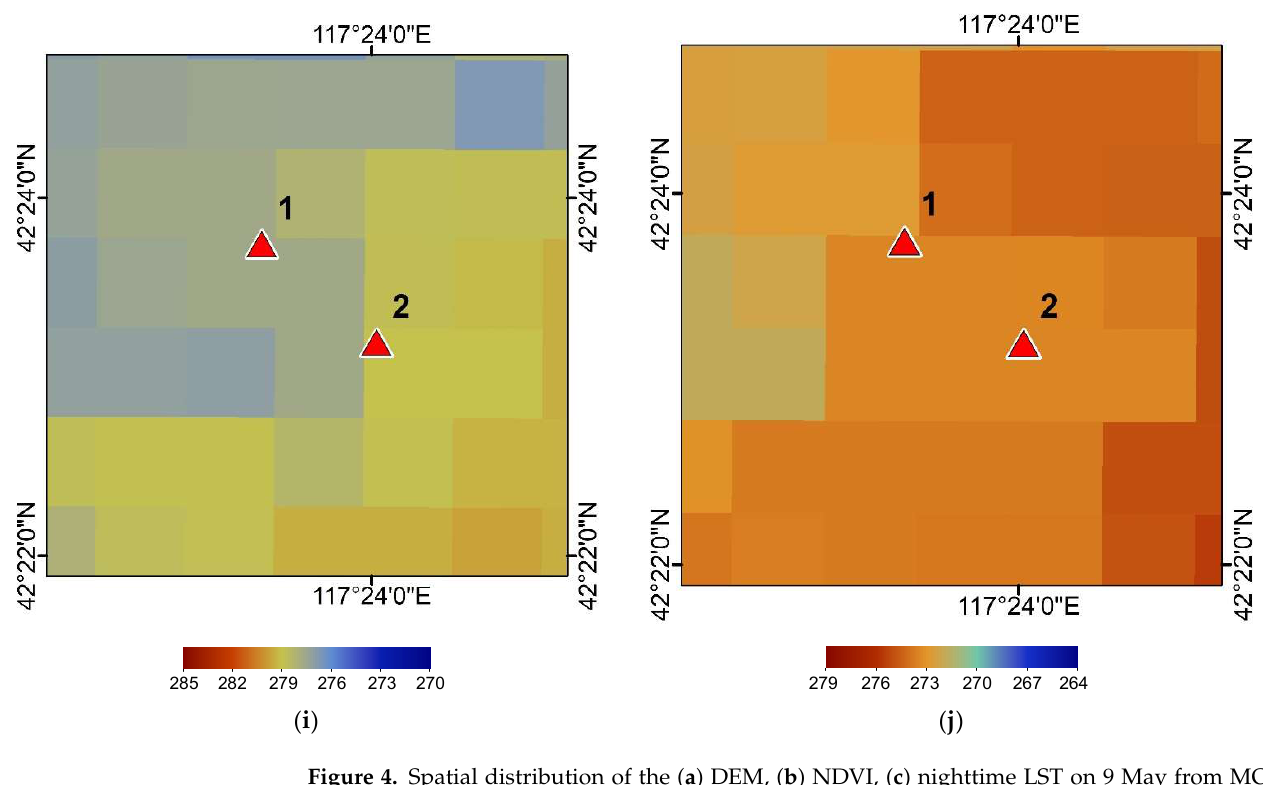
Figure 4. Spatial distribution of the ( a ) DEM, ( b ) NDVI, ( c ) nighttime LST on 9 May from MOD, ( d ) nighttime 30 m LST on 8 May from MYD, ( e ) nighttime 30 m LST on 7 October from MOD, ( f ) nighttime 30 m LST on 7 October from MYD, ( g ) 30 m LST nighttime average for 2019 from MOD, ( h ) 30 m LST nighttime average for 2019 from MYD, ( i ) nighttime 1 km LST on 9 May from MOD, ( j ) nighttime 1 km LST on 8 May from MYD. Note that the LST images are from different acquisition days and times, and thus the legend cannot use the same range.